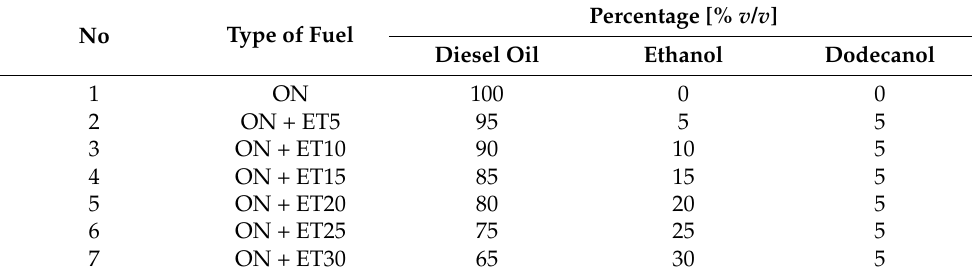
Table 1. List of fuels subjected to tests.